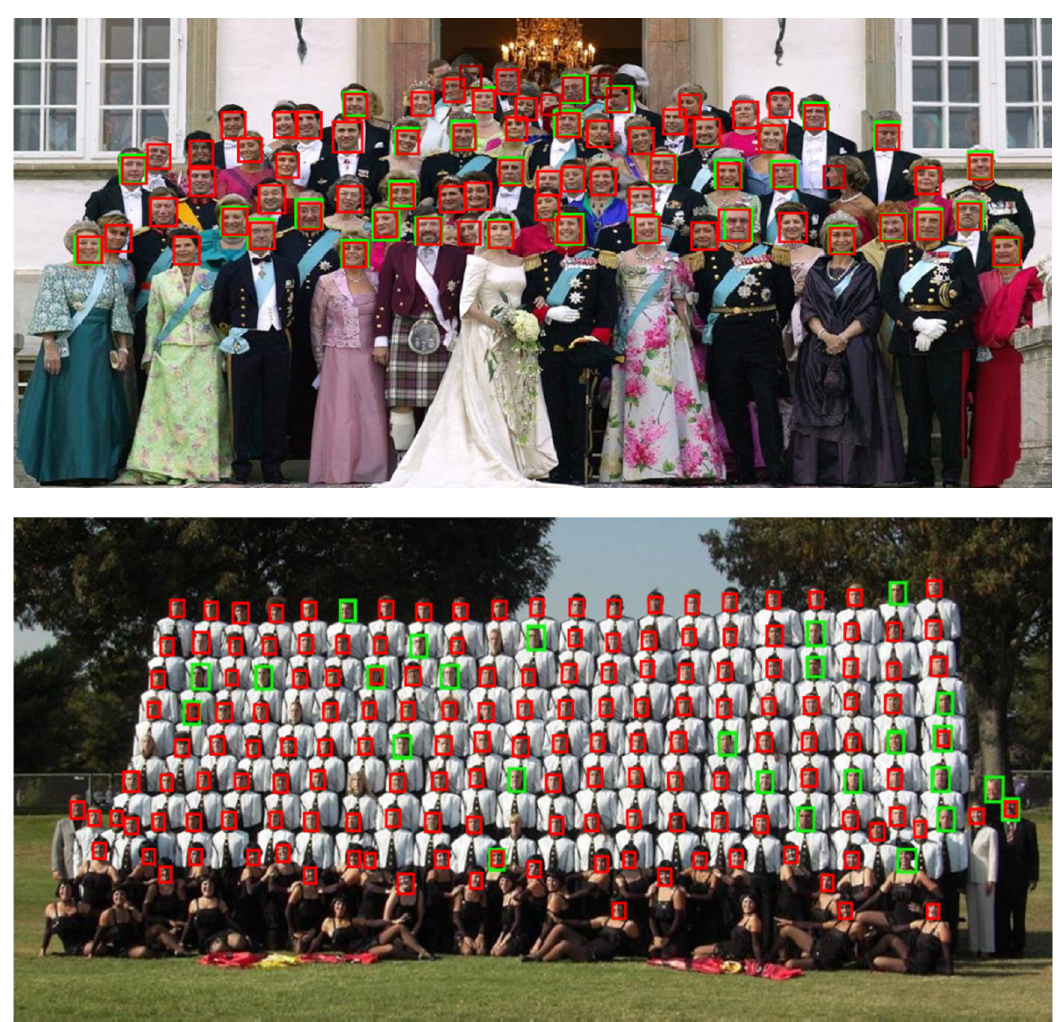
Figure 8. The effect diagram of face detection based on the proposed method. we use the same image to test the effect of R-FCN and the proposed method on small-scale faces. In the same image, the green boxes are the faces detected by R-FCN, and the red boxes are the face detected by the proposed method.